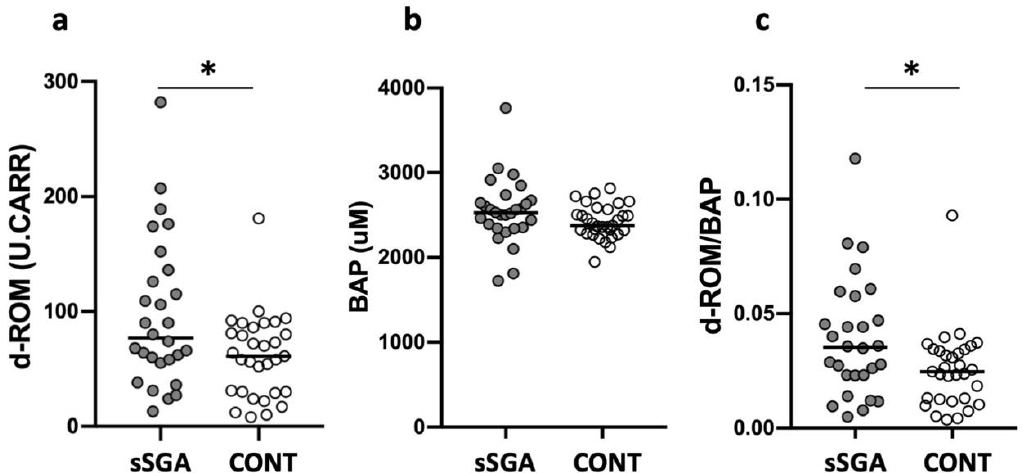
Figure 1. Oxidative stress, antioxidant capacity, and oxidant to antioxidant ratio in sSGA and control infants. White circles represent control infants, and gray circles represent sSGA infants. d-ROM: derivative of reactive oxidative metabolites; BAP: biological antioxidant potential; sSGA: severe small for gestational age; CONT: control. ( a ) d-ROM; ( b ) BAP; ( c ) d-ROM/BAP. * p < 0.05.